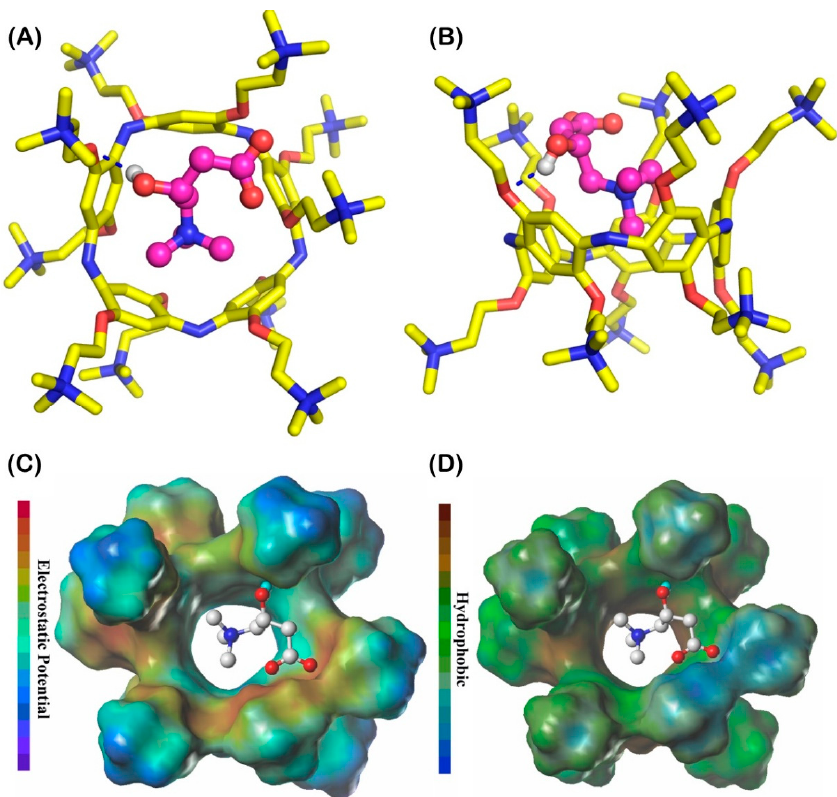
Figure 4. Lowest energy CP5/L-carnitine docked complex for a 1:1 host–guest inclusion ( A is the top view, B is the side view); the electrostatic forces ( C ) (red represents the strongest positive charge and blue represents the strongest negative charge); the hydrophobic interaction ( D ) (brown represents the strongest hydrophobic interaction and blue represents the strongest hydrophilic interaction).